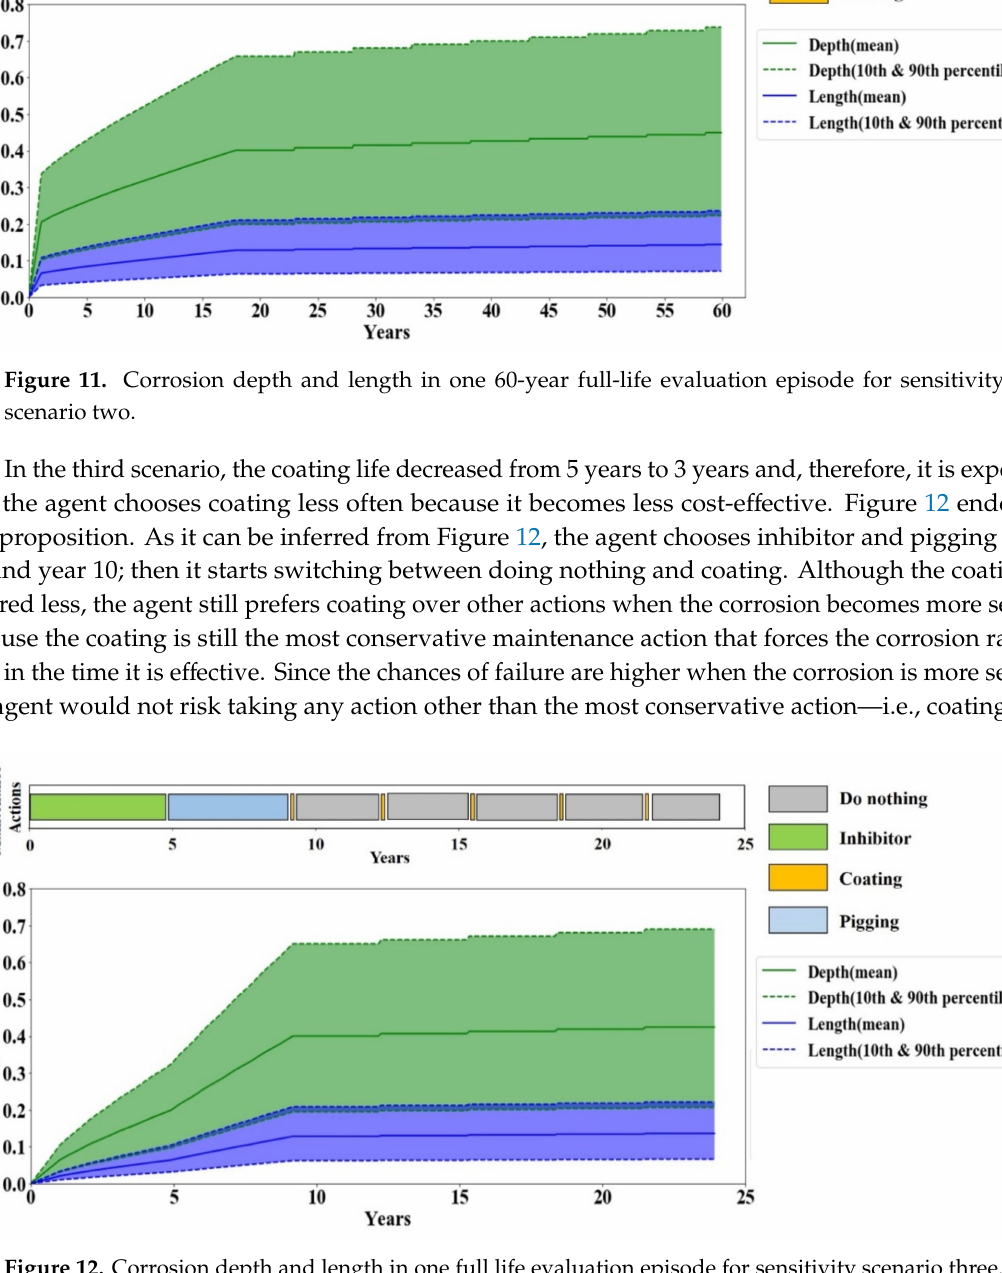
Figure 12. Corrosion depth and length in one full life evaluation episode for sensitivity scenario